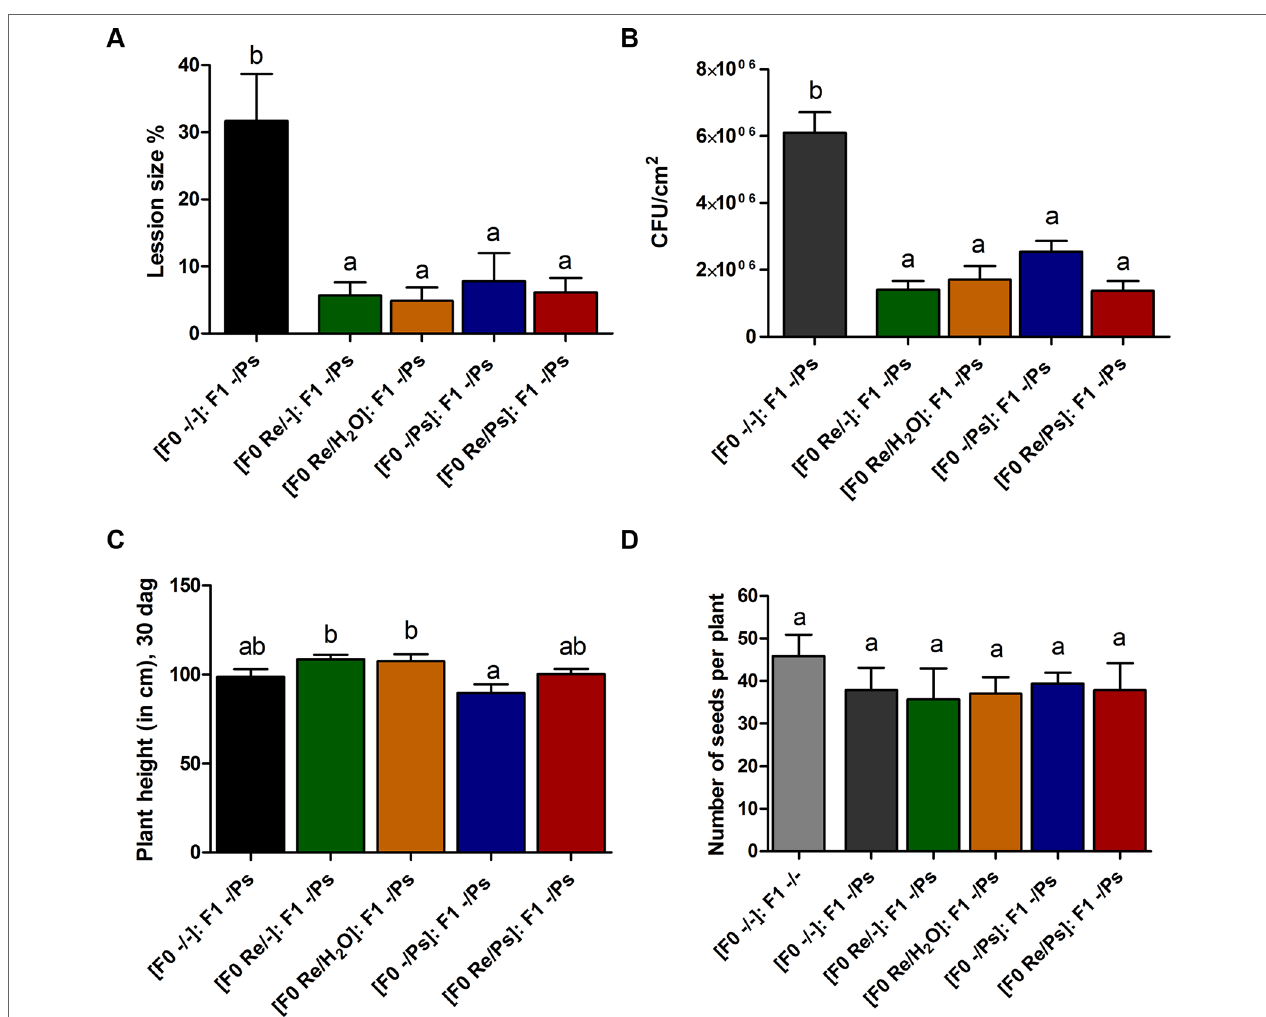
FIGURE 9 | Transgenerational priming effect. (A) Lesion size and (B) colony forming units (CFU) in F1 common bean plants 10 days after infection with PspNPS3121. Data are mean ± SEM from three independent experiments. (C) Plant height 13 days after infection (30 dag). Data are mean ± SEM from 24 independent (n = 24) plants per treatment, from two independent experiments. (D) Number of seeds produced in F1 plants from the different treatments (Re/Ps, Re/H 2 O, Re/-; -/Ps, and -/-). Data are mean ± SD from six independent plants (n = 6) per experiment, from three independent experiments. Statistical significance was determined using one-way ANOVA followed by Tukey’s multiple comparison test, p < 0.05. Means with the same letter are not significantly